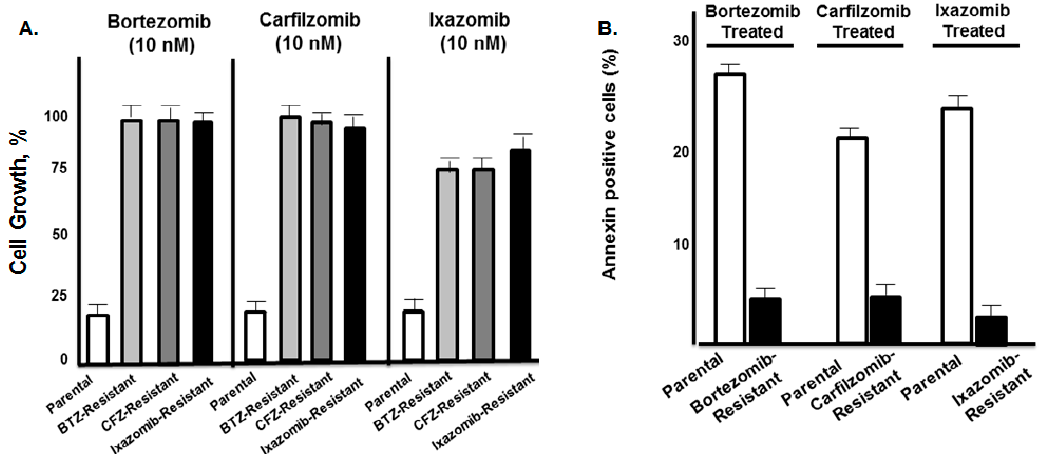
Figure 3. Effect of proteasome inhibitors (PIs) on drug-resistant multiple myeloma (MM) cell lines. ( A ) Effect of PIs on parental and drug-resistant cell viability. Parental, bortezomib (BTZ)-, carfilzomib (CFZ)-, or ixazomib (IXZ)-resistant cells were exposed to bortezomib, carfilzomib, or ixazomib (10 nM). The XTT assay was used to measure the effect of drugs on MM growth and proliferation. ( B ) Effect of PIs on the induction of apoptosis in the parental (drug-sensitive) and drug-resistant RPMI8226 cells. Cells were exposed to each PI (10 nM) for 18 h and the percentage of annexin-positive cells was determined by flow cytometry. Shown is the average of triplicate